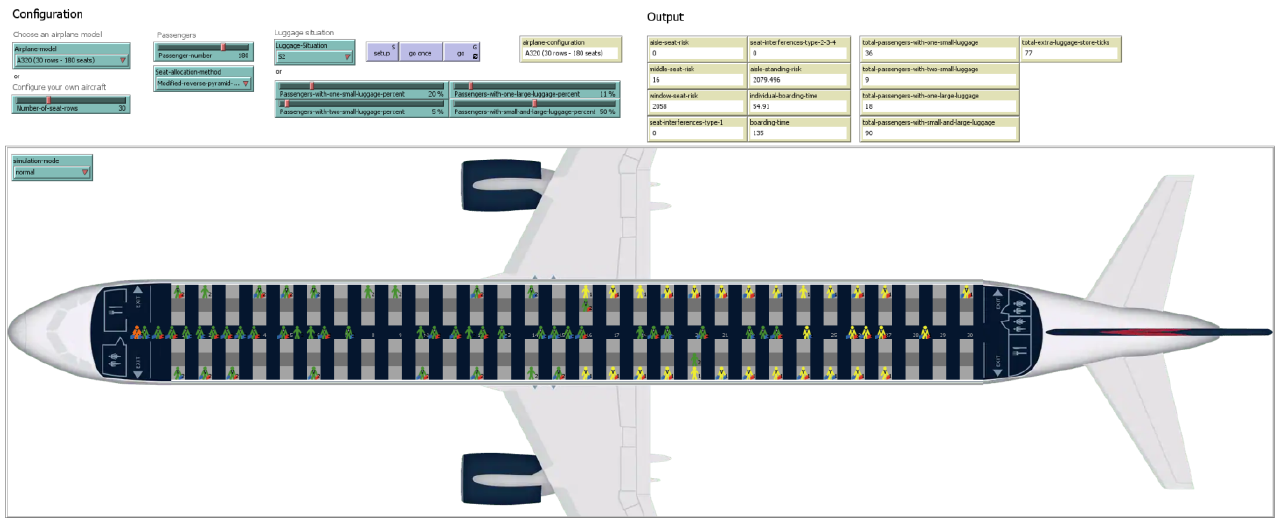
Figure 9. The model’s GUI